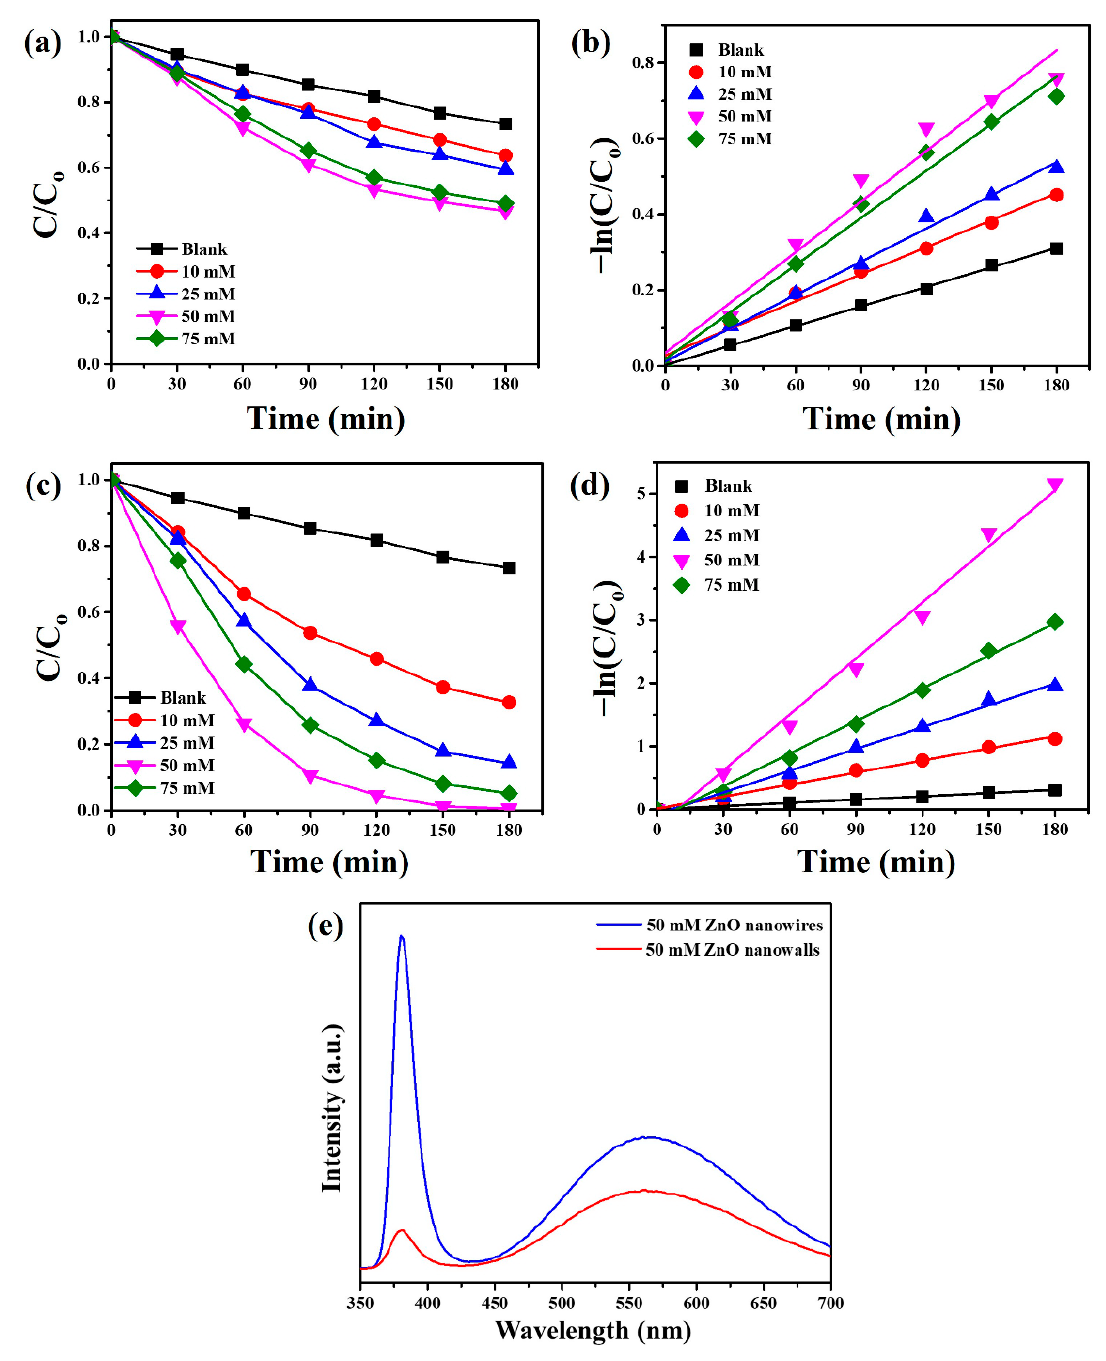
Figure 8. ( a ) Photocatalytic activities and ( b ) kinetic linear simulation curves of ZnO nanowires syn- thesized on the glass substrate with a ZnO seed film at different concentrations of ZnO precursors under UVC light irradiation. ( c ) Photocatalytic activities and ( d ) kinetic linear simulation curves of ZnO nanowalls grown on the Al foil at different concentrations of ZnO precursors under UVC light irradiation. ( e ) CL spectra of ZnO nanowires and ZnO nanowalls grew at the ZnO precursors of 50 mM.